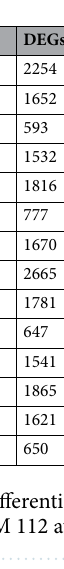
Significant DEGs Common in two cultivars (1214 genes)